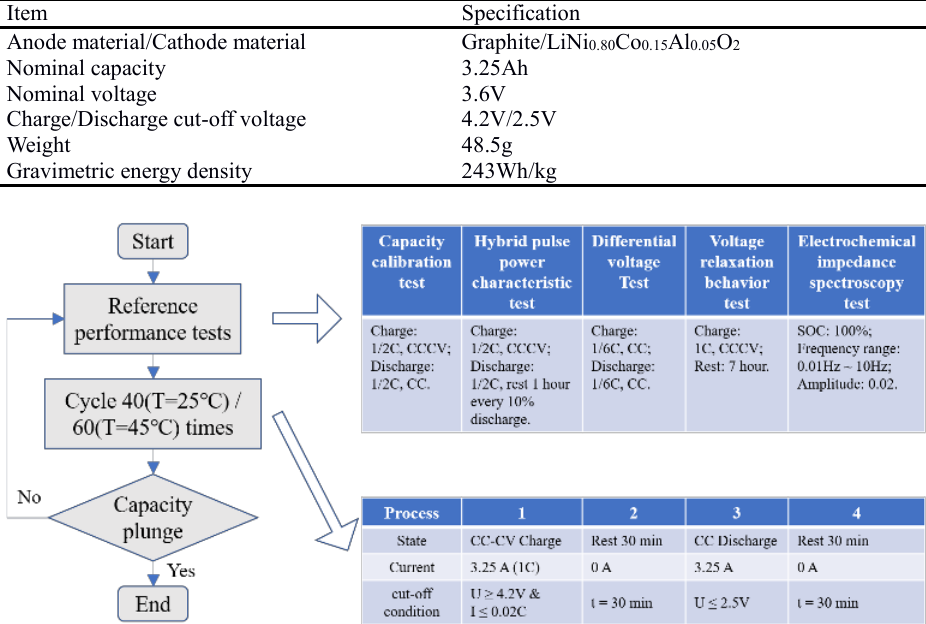
Fig. 1. The flow chart of the cyclic aging